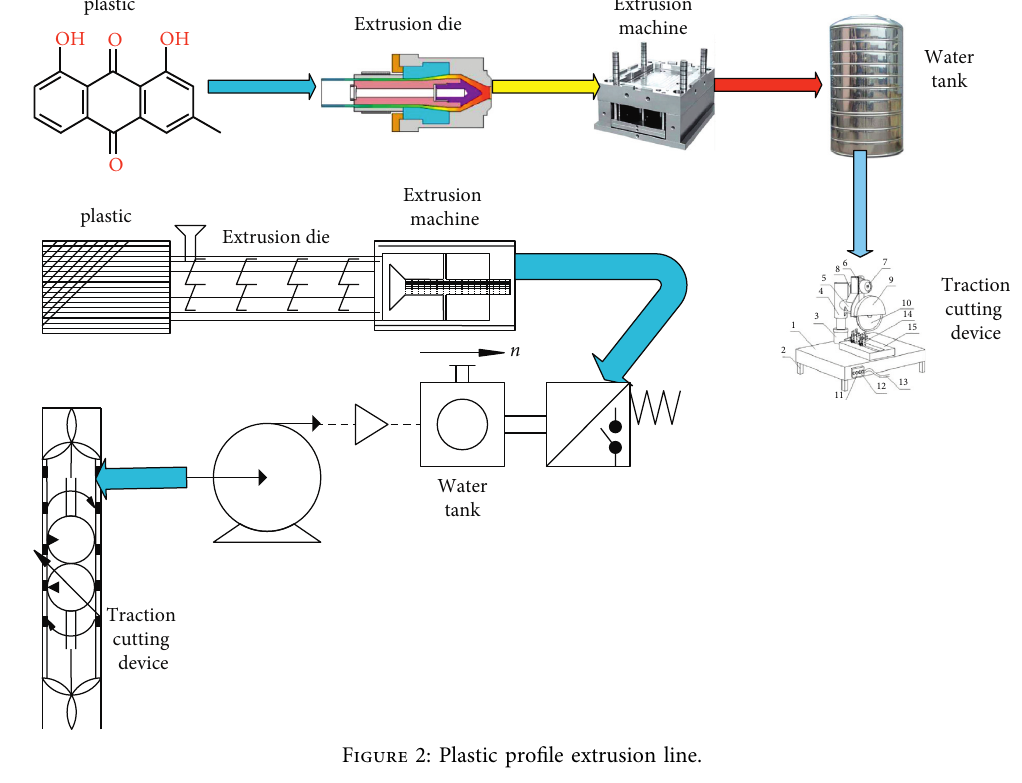
Figure 2: Plastic profile extrusion line.